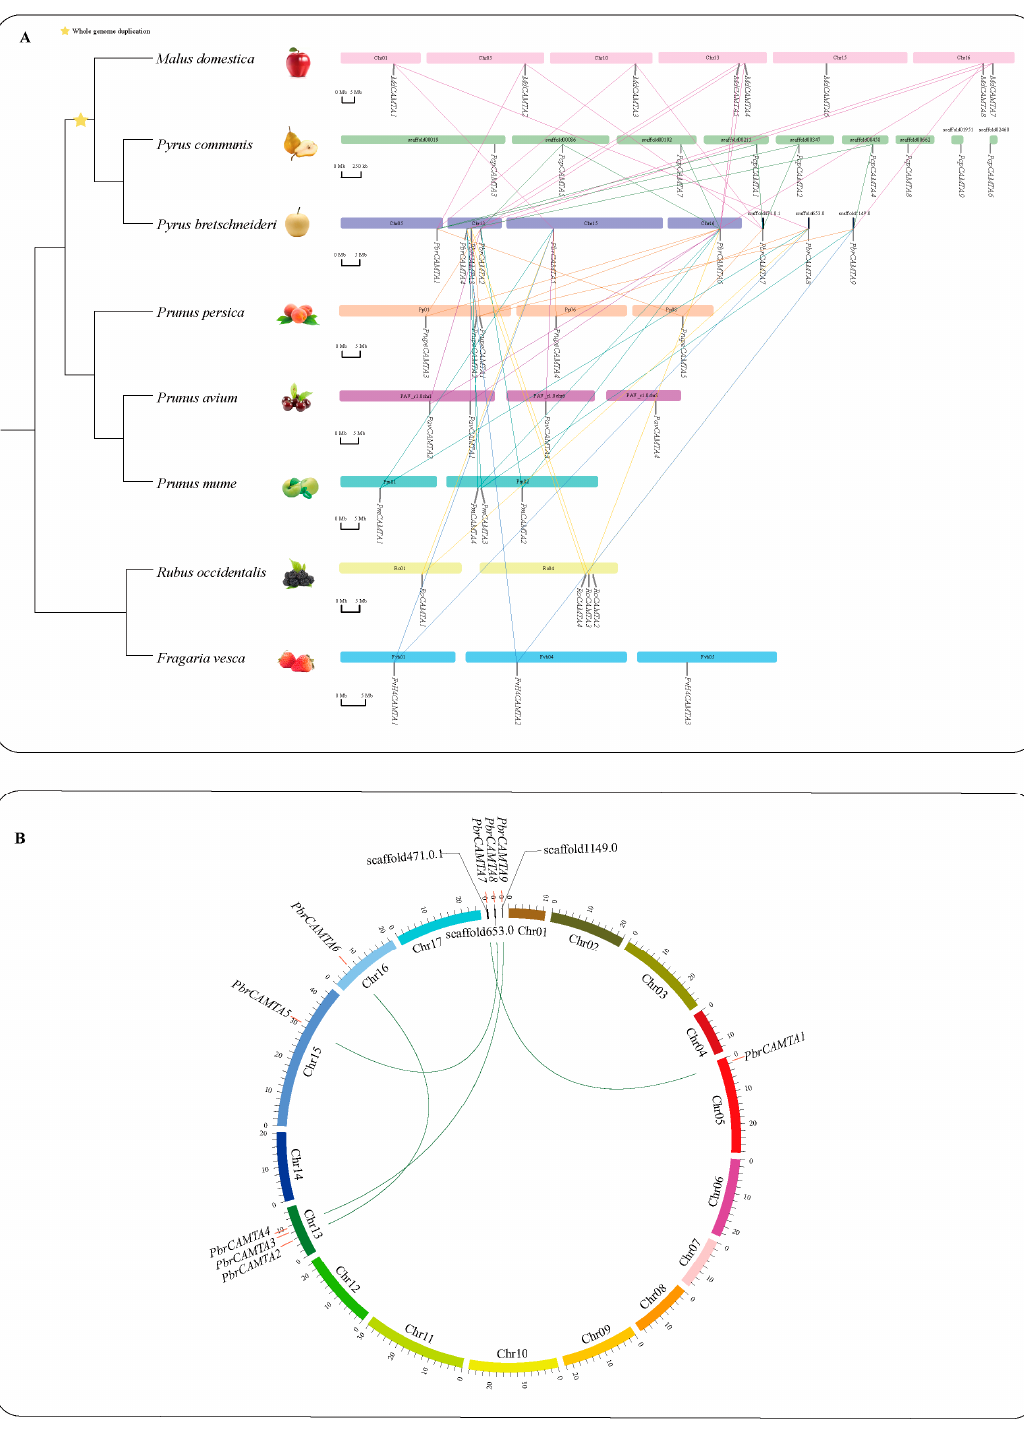
Figure 4. Synteny analysis in Chinese white pear. ( A ) Chromosomal distribution and synteny analysis of pear and seven other species. The chromosomes of different species are shown in different color blocks. Short lines located on different blocks represent the approximate distribution of each CAMTA gene. Long lines denote the details of collinear gene pairs between Chinese white pear and the other seven species. ( B ) Gene location and synteny analysis of PbrCAMTA genes. The homologous genes of the PbrCAMTA family are identified using MCScanX software, and the circle picture was plotted using Circos software (version 0.69.2). Red short lines indicate the position distribution of PbrCAMTA genes on 17 pear chromosomes. Green curves show the collinear gene pairs of the PbrCAMTA gene